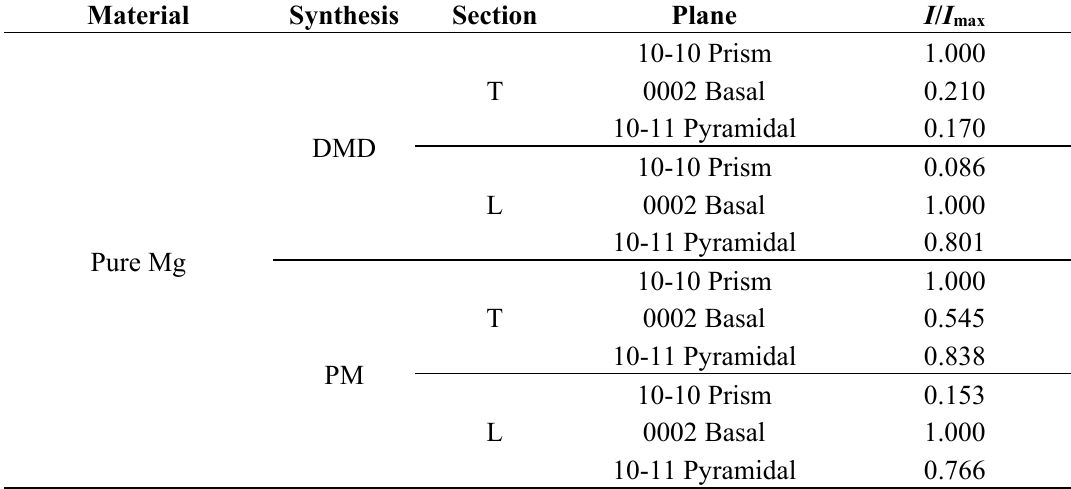
Figure 1. X-Ray diffractograms of TiO 2 nanopowder, pure Mg and Mg-TiO 2 nanocomposites synthesized by DMD ( a ) and ( b ) and PM ( c ) and ( d ) techniques taken: along transverse direction ( a) and ( c ) and along the longitudinal direction ( b ) and ( d ) of the hot extruded samples. X , Y , Z represent 2 θ = 32°, 34° and 36° corresponding to (10-10) prism, (0002) basal and (10-11) pyramidal planes, respectively. Table 2. X-Ray diffractogram results of as extruded Mg-TiO 2 nanocomposites synthesized by DMD and PM